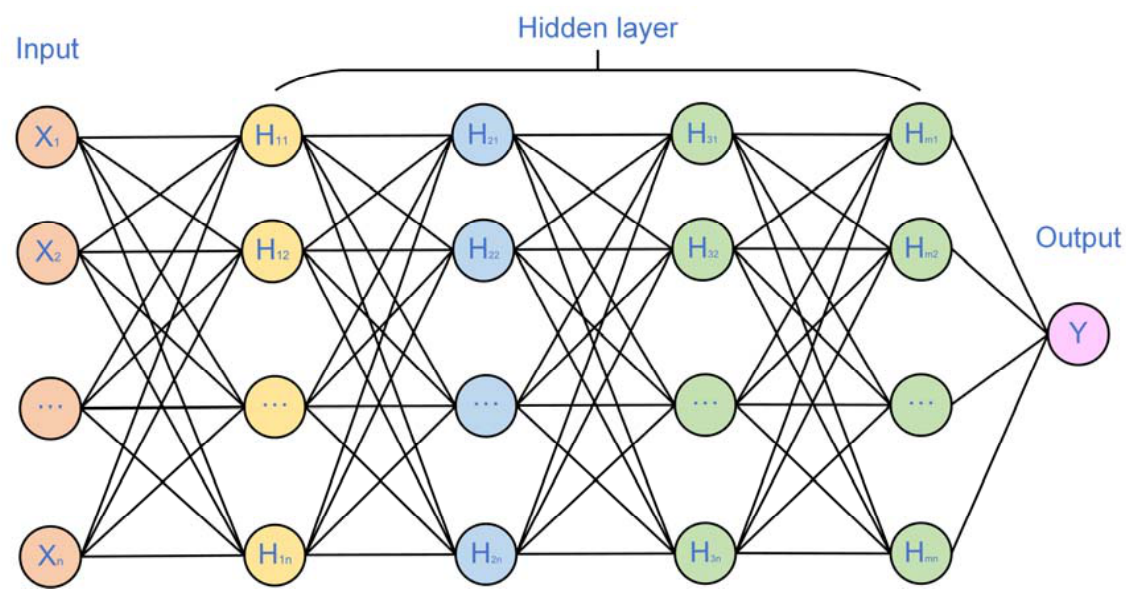
Figure 4. The frame of the DNNR network for regression problems.